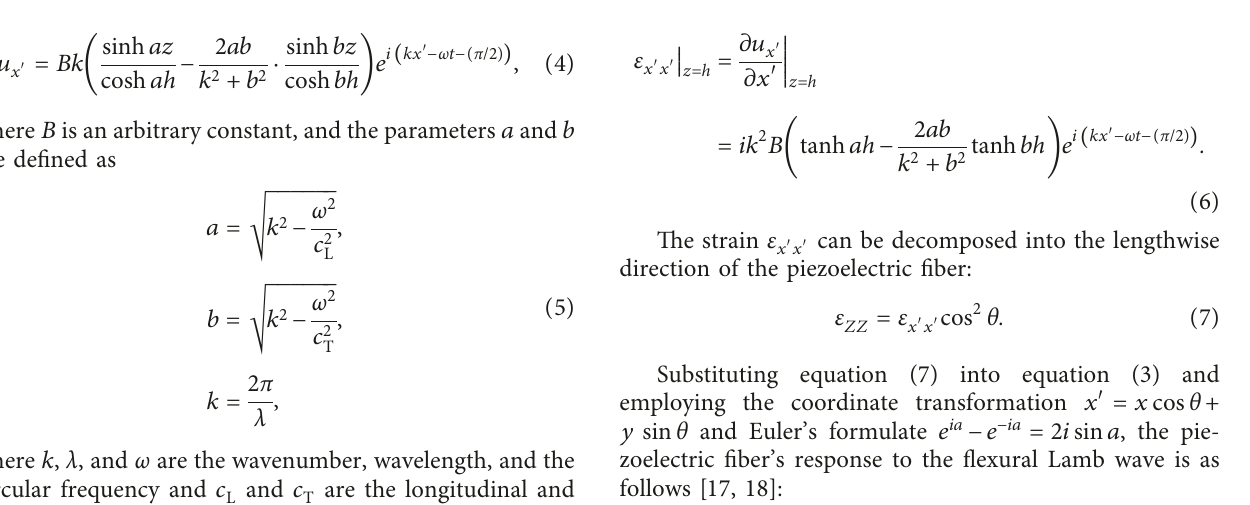
Figure 2: Piezoelectric fiber sensing analysis in local and global coordinate systems: (a) local coordinate system; (b) global coordinate system.